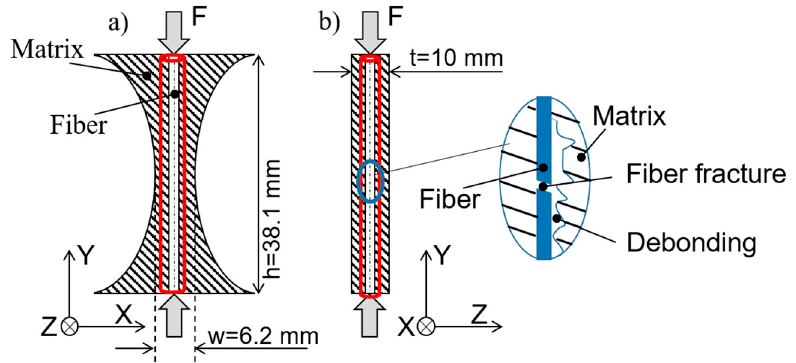
Figure 1. Schematic illustration of the Broutman test specimen geometry (grey), the prepared specimen geometry for X-ray scanning (red) ( a ) front and ( b ) side view. Visualization of the operating force, visualization of the expected resulting failure mechanism.